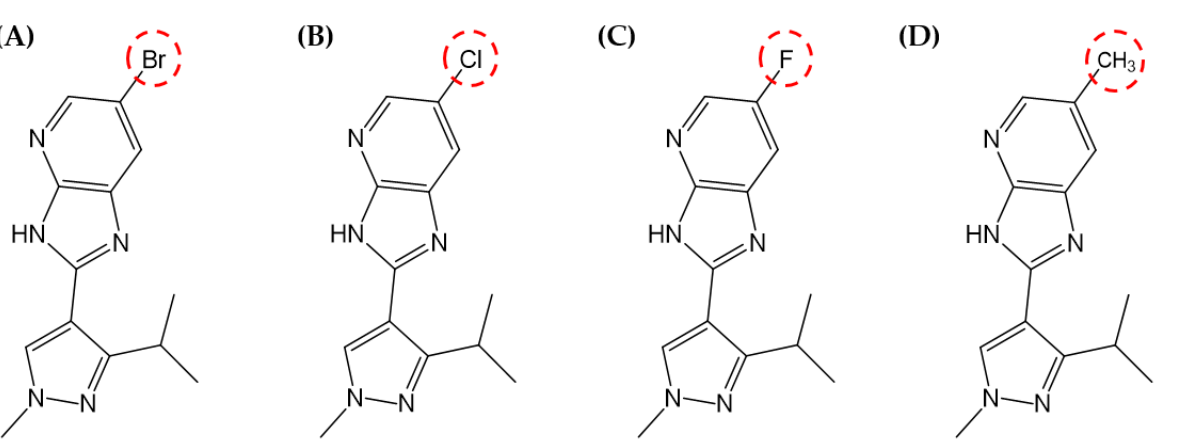
Table 1. Docking score, binding energy, PIE, and in vitro assay results for compounds 1 – 4 against